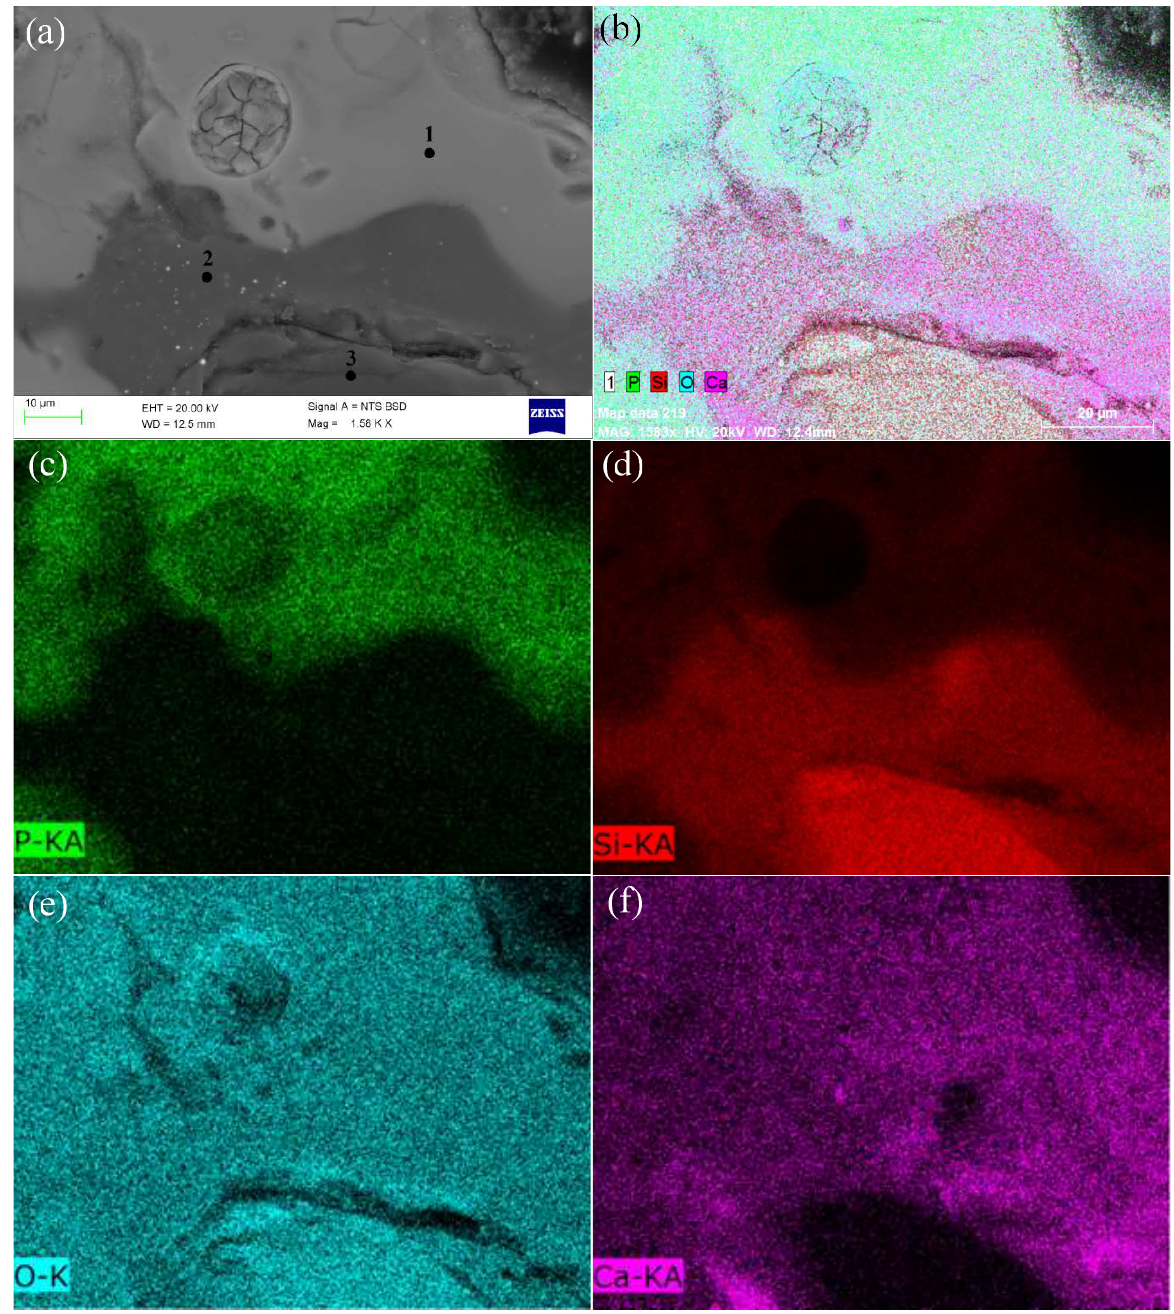
Figure 14. SEM–EDS images of slag phase: ( a ) SEM image; ( b ) the surface scanning analysis of P, Si, O, and Ca elements; ( c ) the surface scanning analysis of P elements; ( d ) the surface scanning analysis of Si elements; ( e ) the surface scanning analysis of O elements; and ( f ) the surface scanning analysis of Ca elements.